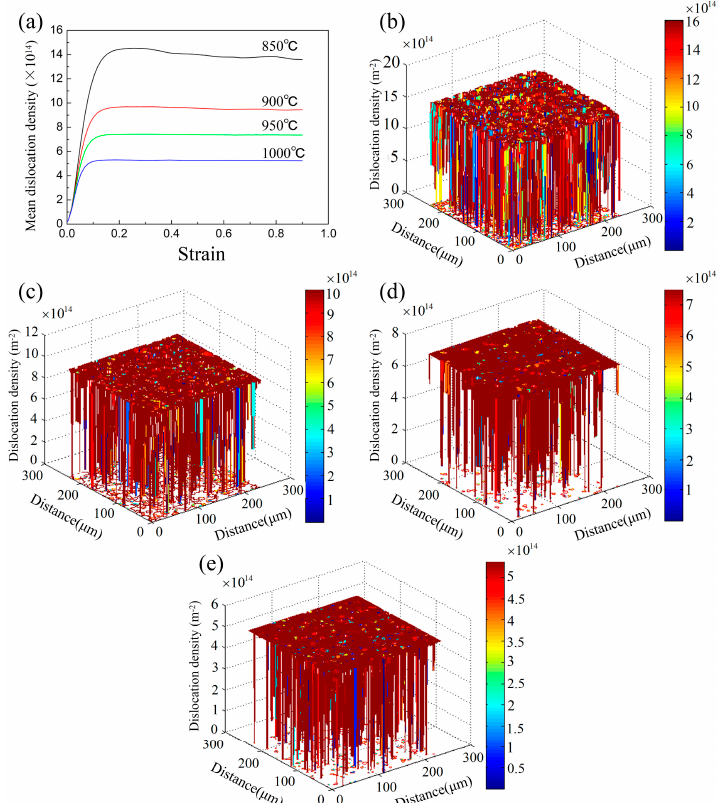
Figure 10. Dislocation density of FeMnSiCrNi SMA under dynamic recrystallization (DRX) at the various deformation temperatures at the strain rate of 0.5 s − 1 based on CA: ( a ) variation of dislocation density with strain at the various temperatures; ( b ) ε = 0.9, 850 °C; ( c ) ε = 0.9, 900 °C; ( d ) ε = 0.9, 950 °C; ( e ) ε = 0.9, 1000 °C. Metals 2019 , 9 , x FOR PEER REVIEW 11 of 13